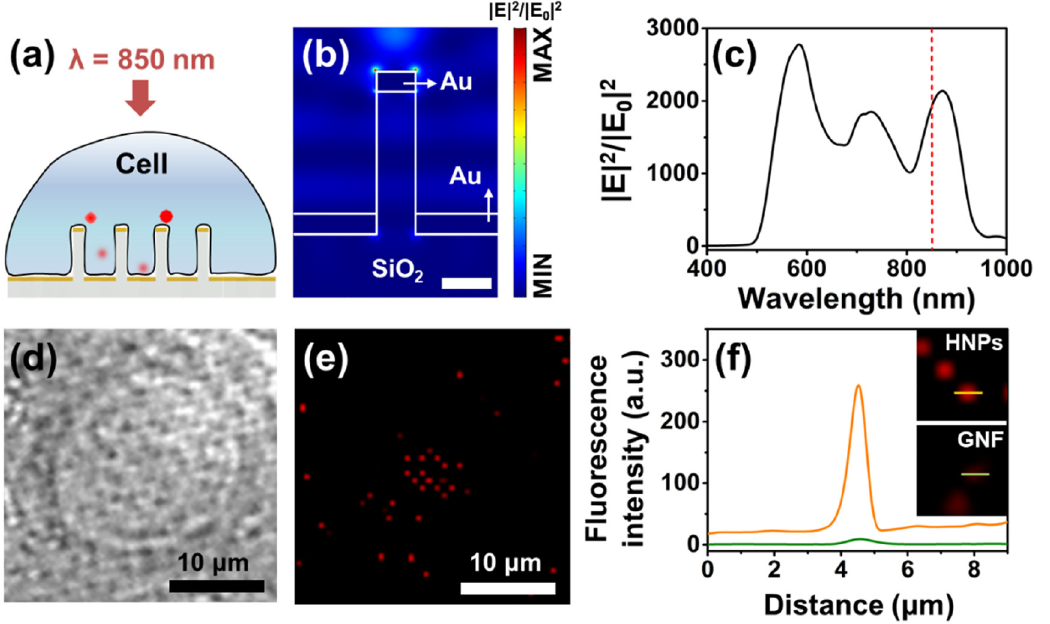
Figure4: Two-photonexcitationofHNPswithinlivingcellsforinvestigatingthecapabilityforhigh-resolutiondetectionofEGFstransportedin the nucleus. (a) Schematic illustration of the two-photon excited fluorescence concentration of intracellular epidermal growth factor (EGF) treatedwithAlexa647coupledwithgoldcapsofHNPs.(b)Calculatednear-fieldintensitydistributionofHNPsunder850nmlaserillumination (scale bar: 200 nm). (c) Simulated intensity enhancement over the wavelength range from 400 to 1000 nm at the gold cap of HNPs to confirm the validity of plasmonic focusing generationfor two-photon excitation. (d) Bright field images of HeLa cells cultured on HNPs.(e) Fluorescent visualization of intranuclear EGF-attached Alexa 647 (red channel) in HeLa cells. (f) Comparison of the fluorescence signal intensities of EGF molecules under the interaction with the gold cap of HNPs and on a